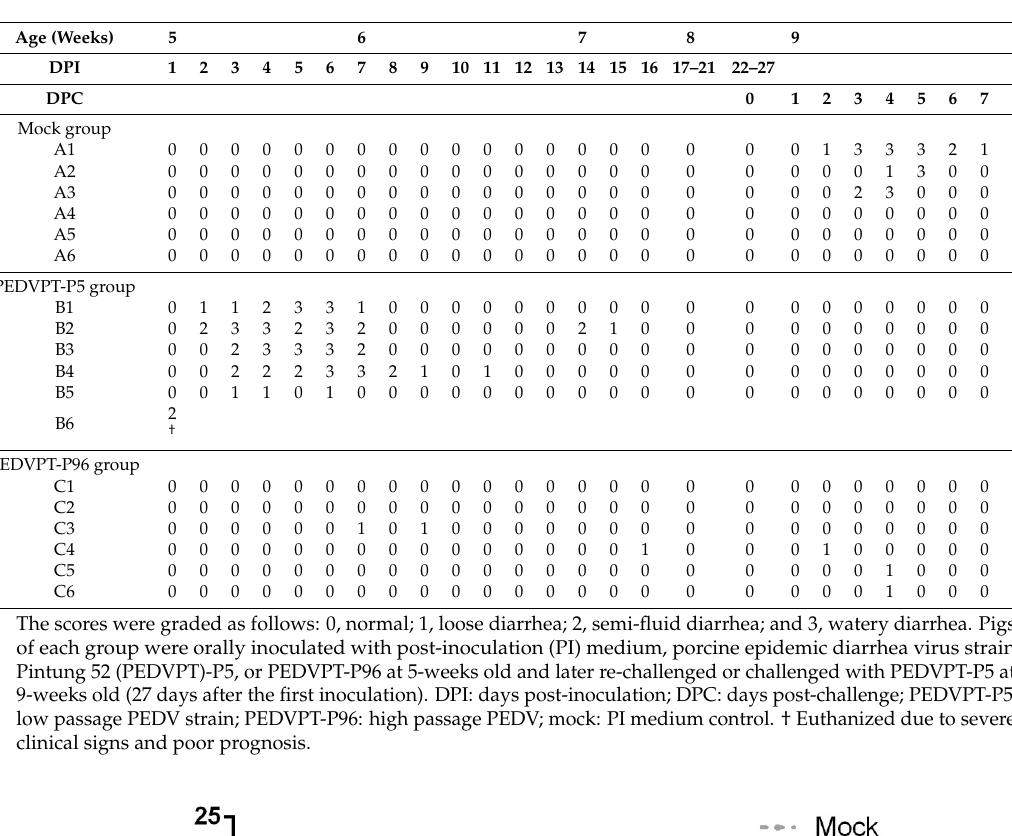
Table 1. Clinical scoring of fecal consistency.